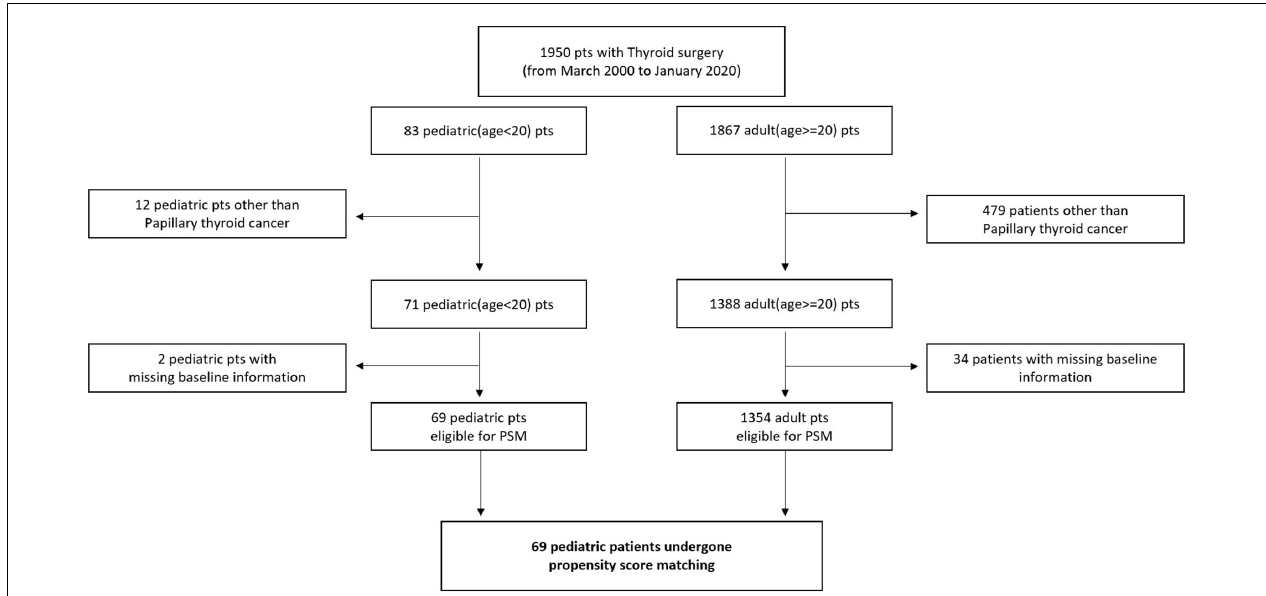
FIGURE 1 | Study design